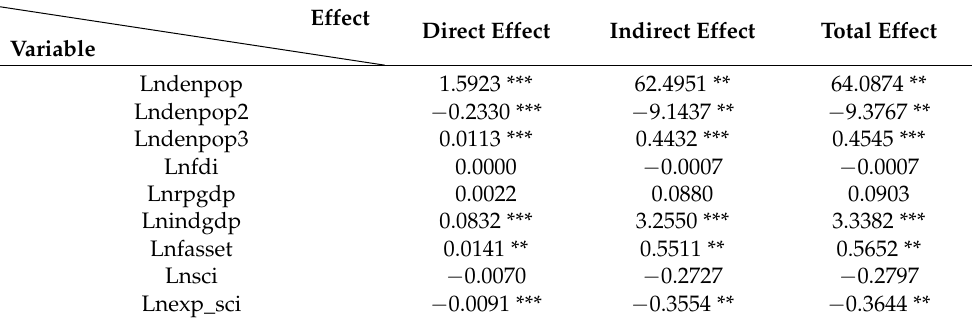
Table 5. Direct, Indirect, and Total Effects of Different Factors on Haze Pollution. Effect Direct Effect Indirect Effect Total Variable